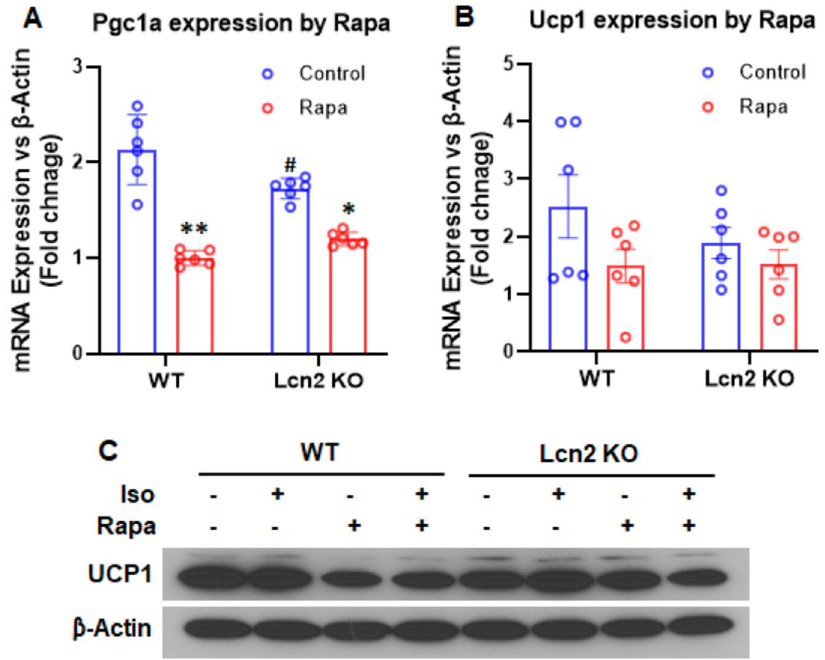
Figure 5. Effect of mTORC1 inhibition by rapamycin on thermogenic gene and protein expression in inguinal adipocytes. ( A , B ) The mRNA expression of Pgc1α and Ucp1 genes by rapamycin in Lcn2 KO adipocytes, respectively. ( C ) The protein expression of UCP1 by rapamycin in Lcn2 KO adipocytes. Results are presented as mean ± SEM (n = 6 for ( A , B )). * p < 0.05, ** p < 0.01 versus controls. # p < 0.05, ## p < 0.01 versus WT adipocytes.